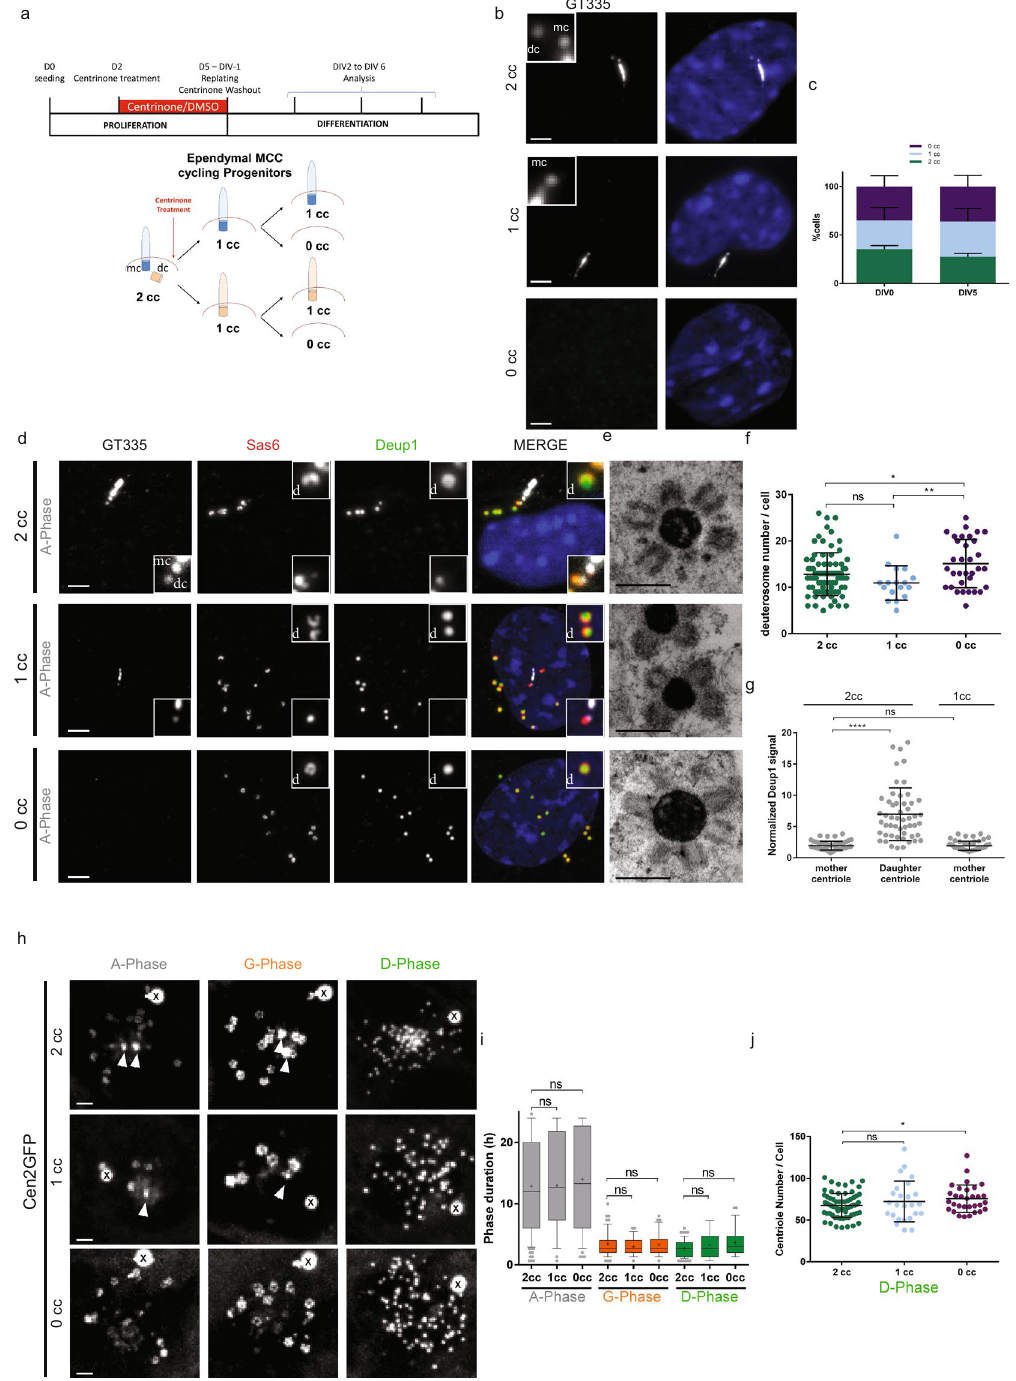
Figure 3. Depletion of centrosomal centrioles only slightly affects centriole amplification in brain MCC. ( a ) Experimental procedure used to deplete centrosomal centrioles in MCC cycling progenitors using centrinone. See methods. 2cc, 1cc or 0cc for 2, 1 or 0 centrosomal centriole(s), respectively. ( b ) Representative pictures of 2cc, 1cc or 0cc ependymal progenitor cells stained with GT335. ( c ) Repartition of 2cc, 1cc or 0cc cell populations at two different days of differentiation (DIV for Day In Vitro ). Cells selected for this quantification are ependymal progenitors that have not started centriole amplification (« centrosome » stage; n = 912 and 566 cells at DIV0 and DIV5 respectively). ( d ) Representative GT335, Deup1 and Sas6 immunostainings of 2cc, 1cc or 0cc cells during A-Phase. Zoom in pictures highlight deuterosomes « d » and centrosomal centrioles (mc: mother centriole and dc: daughter centriole). ( e ) Representative EM pictures of deuterosomes in 2cc, 1cc or 0cc cells. The status of the centrosome was identified by correlative light and electron microscopy. ( f ) Quantification of deuterosome number per cell in 2cc, 1cc or 0cc cells during G-Phase. 2cc cells have been taken from DMSO and centrinone-treated cultures (n = 80, 17, 33 cells for 2cc, 1cc and 0cc, respectively). ( g ) Normalized